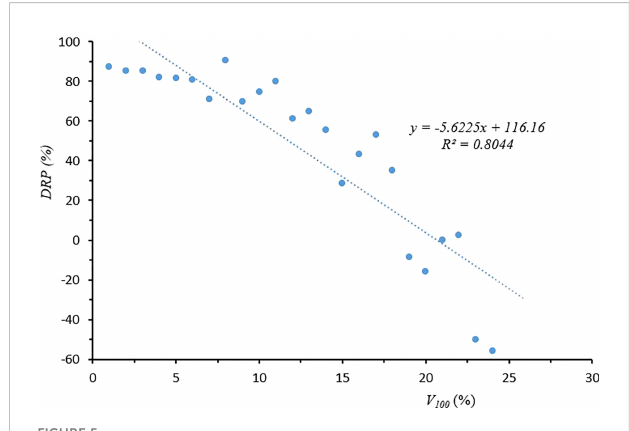
FIGURE 5 Correlation between droplet size characteristics V100 and drift reduction percentage (DRP).